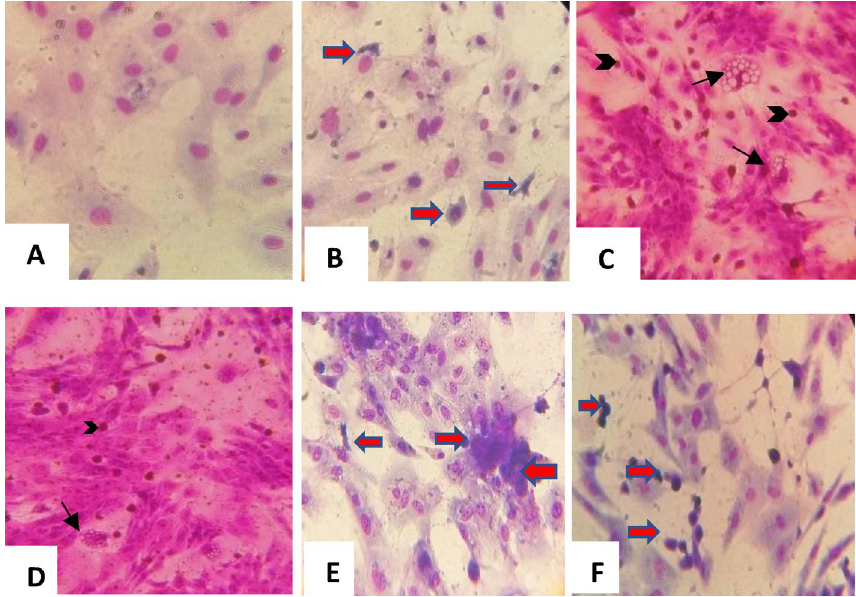
Figure 1. Giemsa staining of RVFV, SPPV and LSDV viruses for coinfection of LT cell culture (× 400). ( A ) Mock cells. ( B ) RVFV cytopathic effect: RVFV necrotic foci (red arrows). ( C ) SPPV effect ( D ) LSDV, ( E ) SPPV/ RVFV 0.01/0.01 coinfection of LT cells and ( F ) LSDV/RVFV coinfection. Capripoxvirus induced cellular damage. Arrows showing capripox virus-induced vacuoles in cells and intracytoplasmic eosinophilic inclusion bodies (Arrowheads).